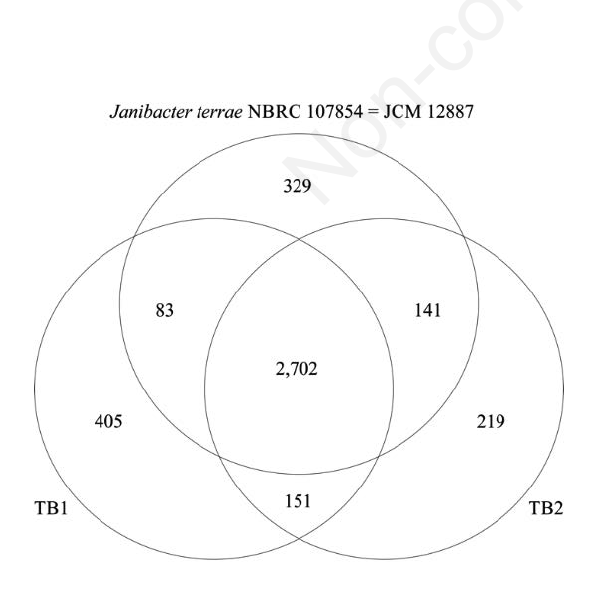
Figure 2. Ring image displaying the similarity of the two isolates from valve tissues of a patient with aortic stenosis with Janibacter terrae (strain NBRC 107854 = JCM